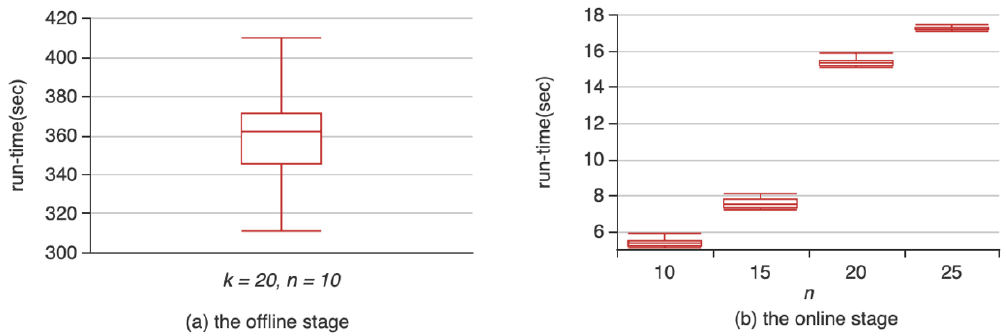
Figure 5. Execution time of ( a ) offline stage and ( b ) online stage.